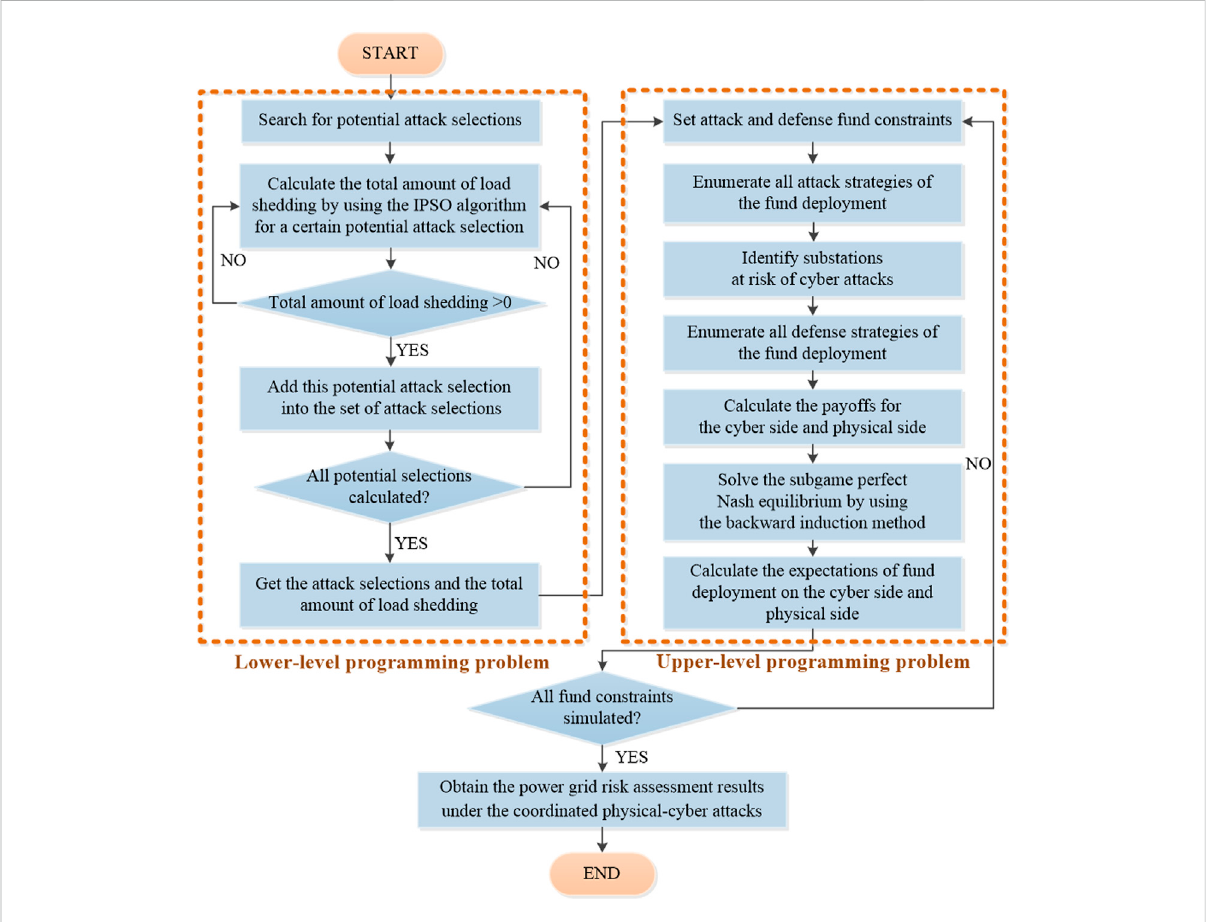
FIGURE 5 Flow chart of the converted bi-level programing model